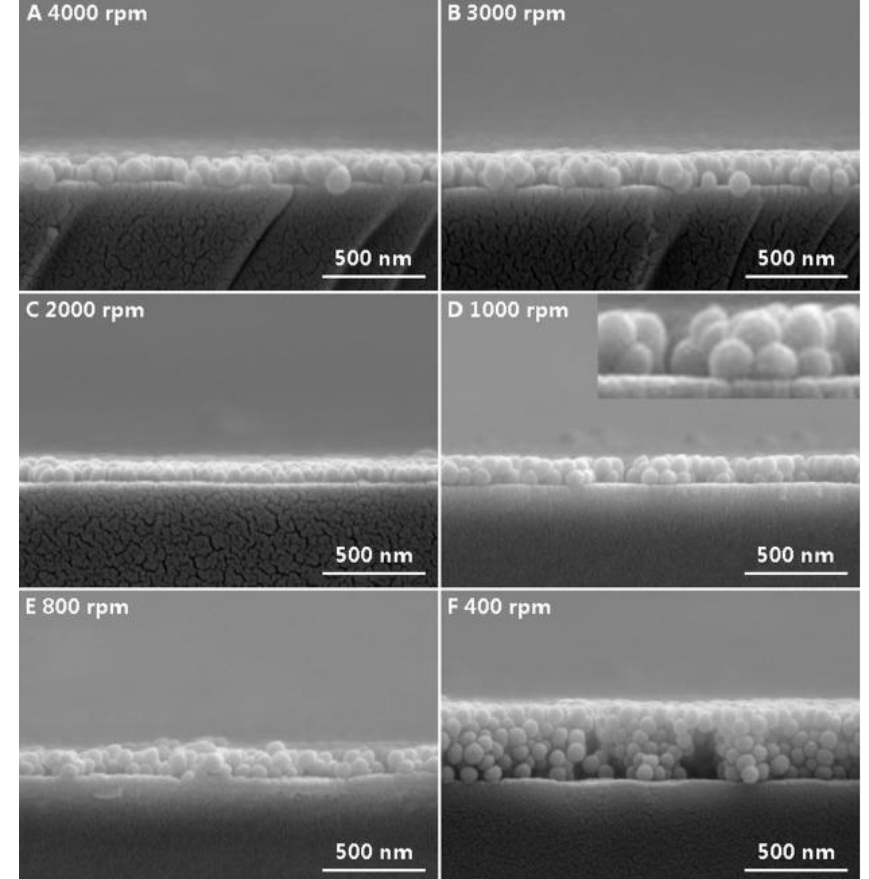
Figure 7. Cross sectional FESEM images of SiO 2 nanosphere coatings prepared at ( A ) 4000 rpm, ( B ) 3000 rpm, ( C ) 2000 rpm, ( D ) 1000 rpm, ( E ) 800 rpm, and ( F ) 400 rpm. Reprinted with permission [72]; 2018, Elsevier.